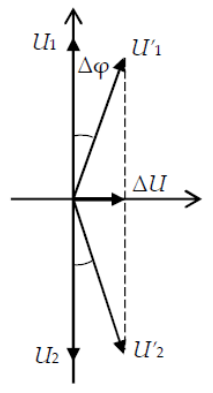
Figure 12. The informative signal Δ U proportional to the rotation velocity Ω (where U 1 , U 2 are the